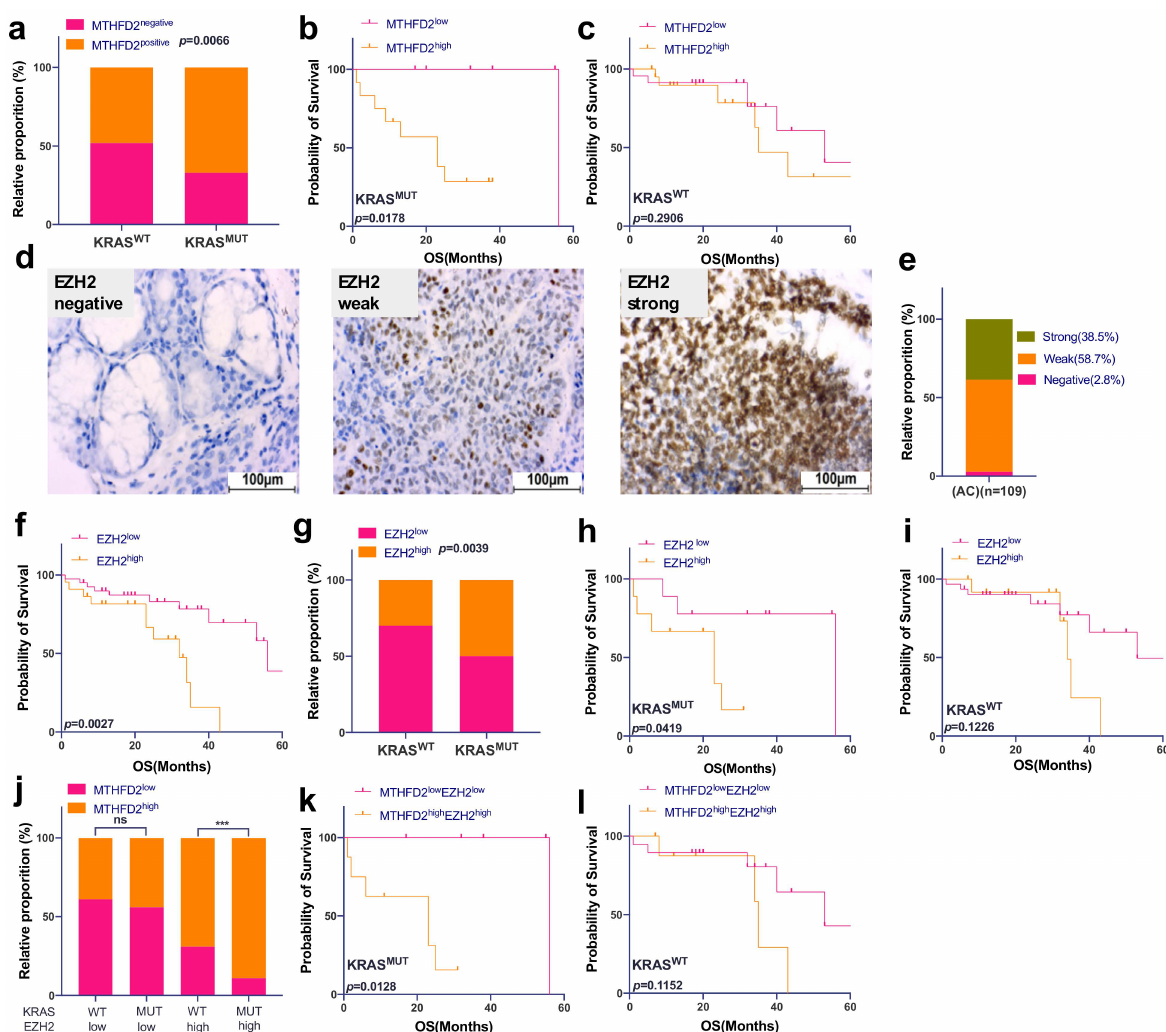
Figure 1. EZH2 and MTHFD2 expression correlate with KRAS mutation status and patient sur- vival in AC patients. ( a ) Correlation between MTHFD2 protein expression and KRAS gene mutation in AC samples ( p = 0.0066). ( b ) Kaplan–Meier survival analysis of AC according